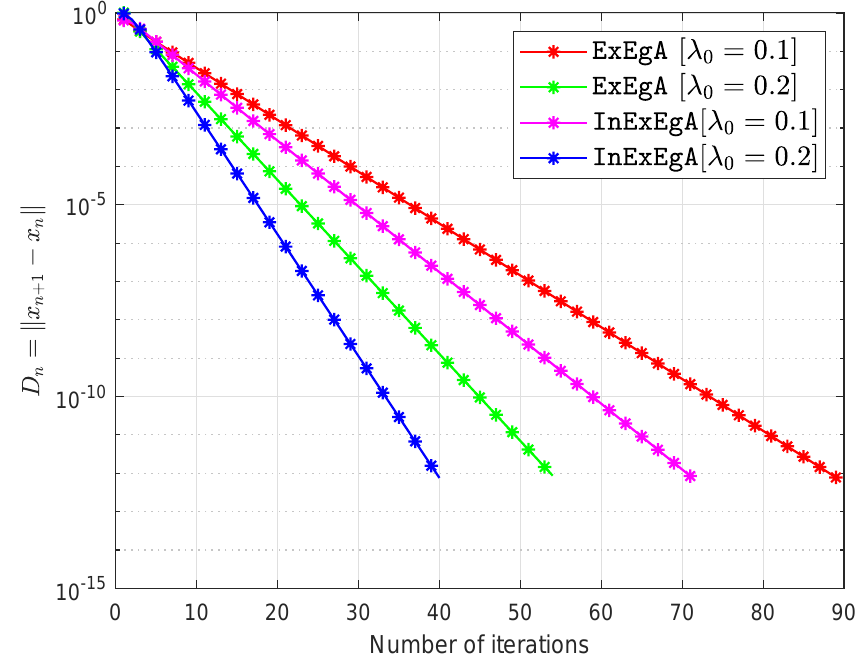
Figure 1. Algorithm 1 comparison with Algorithm 1 in [16] in term of iterations when n = 5.